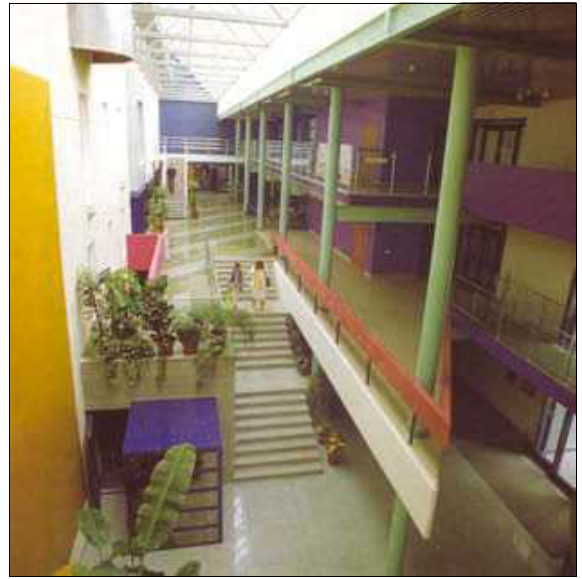
Fig. 16. complex “centr­u­m“ in Vilniu­s. a­r­chitects k. Pempė,